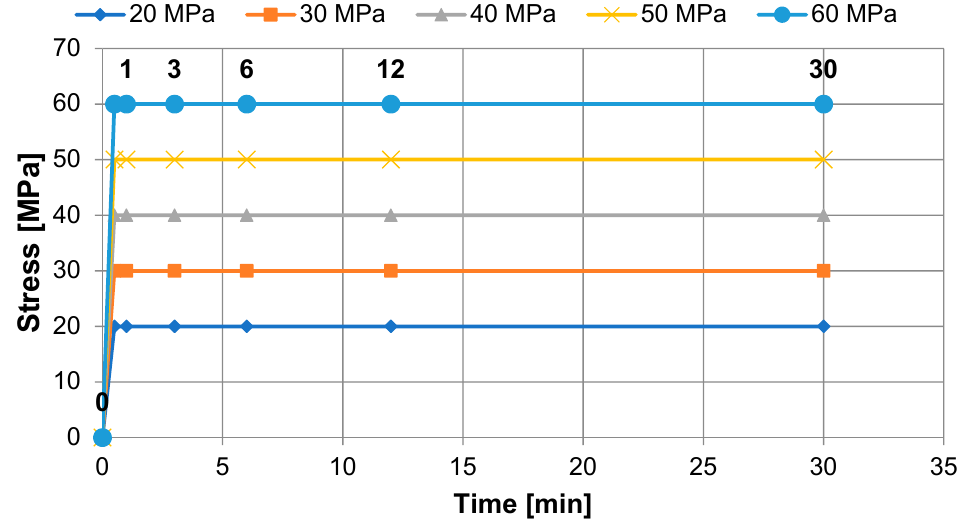
Figure 5. Diagram of the creep test.